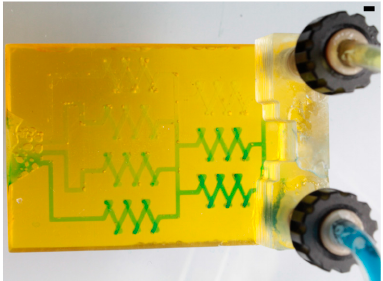
Figure 4. Gradient generation in a 3D printed PFPE microfluidic chip with a channel height and width of 800 µm. The upper entrance is filled with a yellow ink, the lower entrance is filled with a blue ink (scale bar: 2 mm).